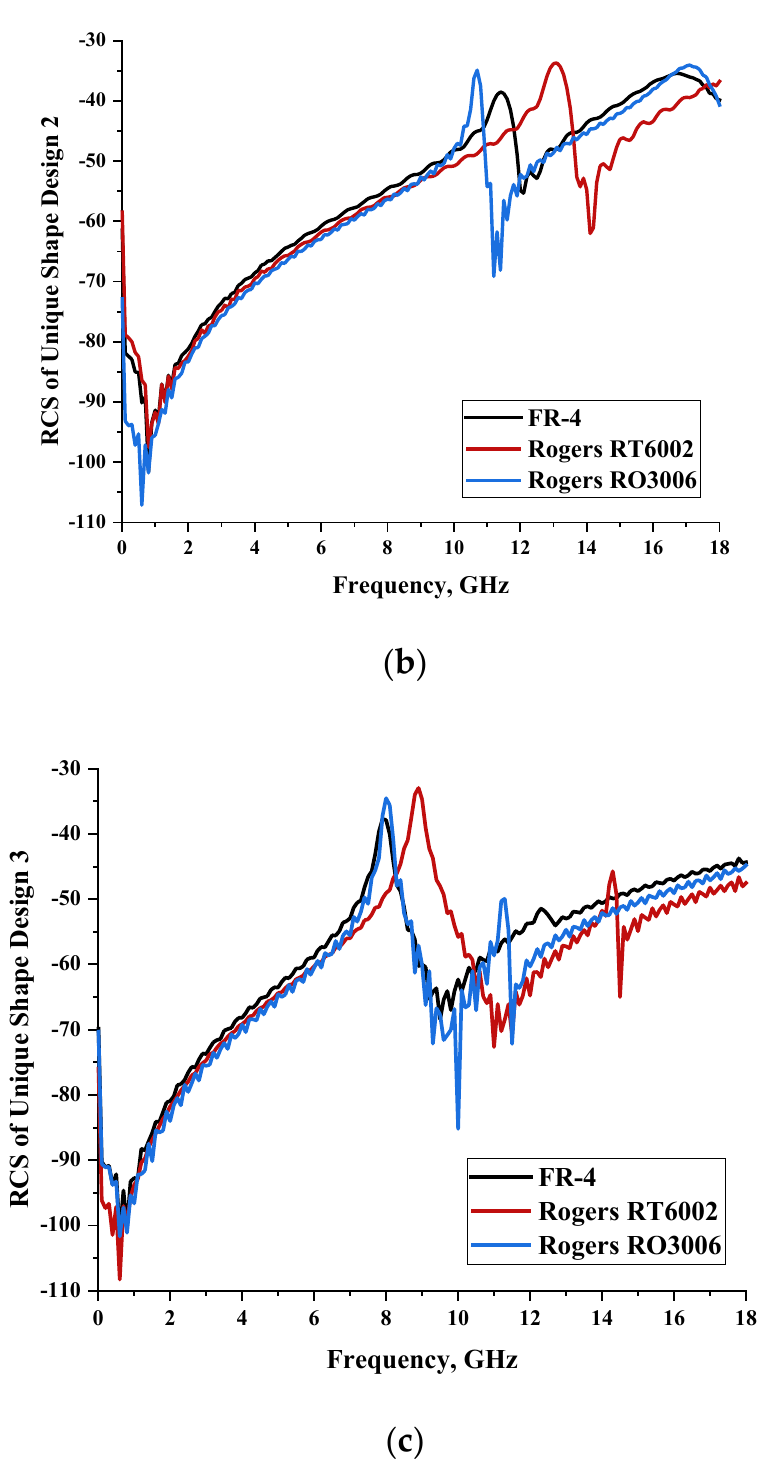
Figure 4. Monostatic RCS values for uniquely shaped metamaterial unit-cell design with various substrate materials: ( a ) Design 1; ( b ) Design 2; and ( c ) Design 3.